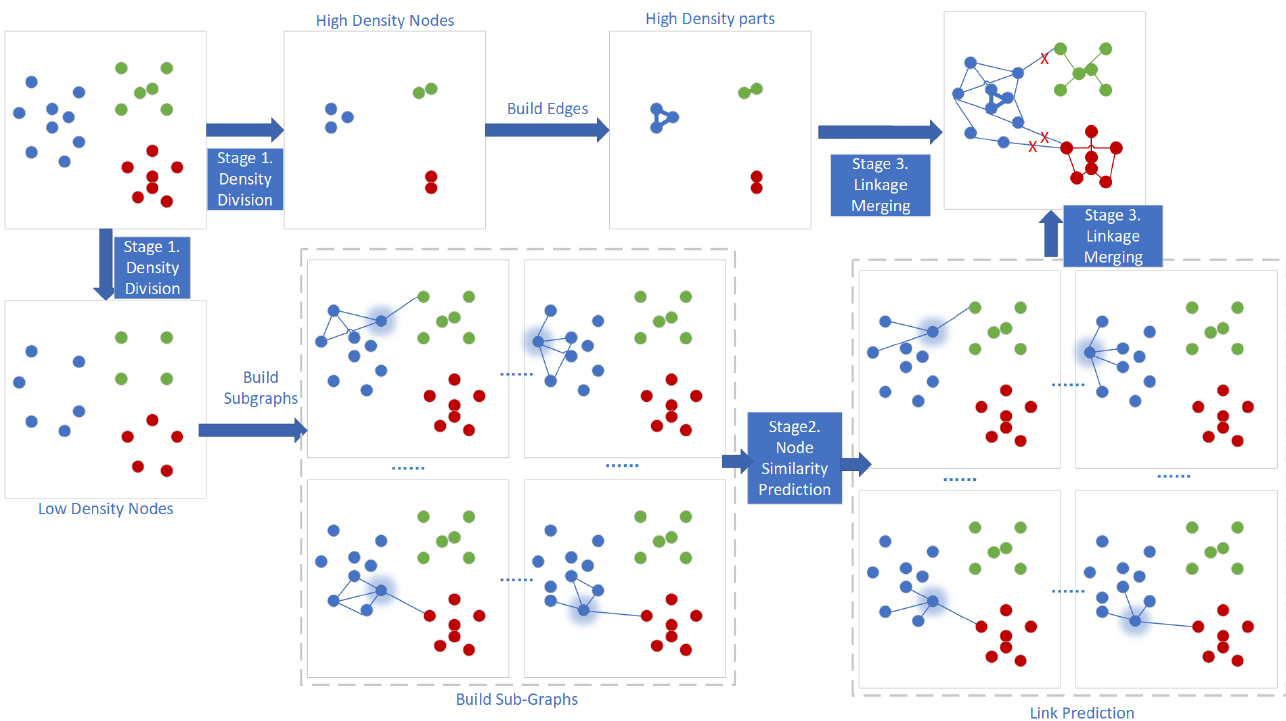
Figure 1. The framework of DDC-GNN. Firstly, the face data are divided into high-density and low-density parts. The high-density parts are located at the center of the cluster and have strong connectivity. Secondly, we use each data point of the low-density parts as a node, and construct an ASG for each node only in low-density parts, then apply GNN on ASGs to predict the connectivities among the nodes. After that, all the nodes are connected into a big graph with their linkage and clusters are obtained by iteratively deleting unnecessary